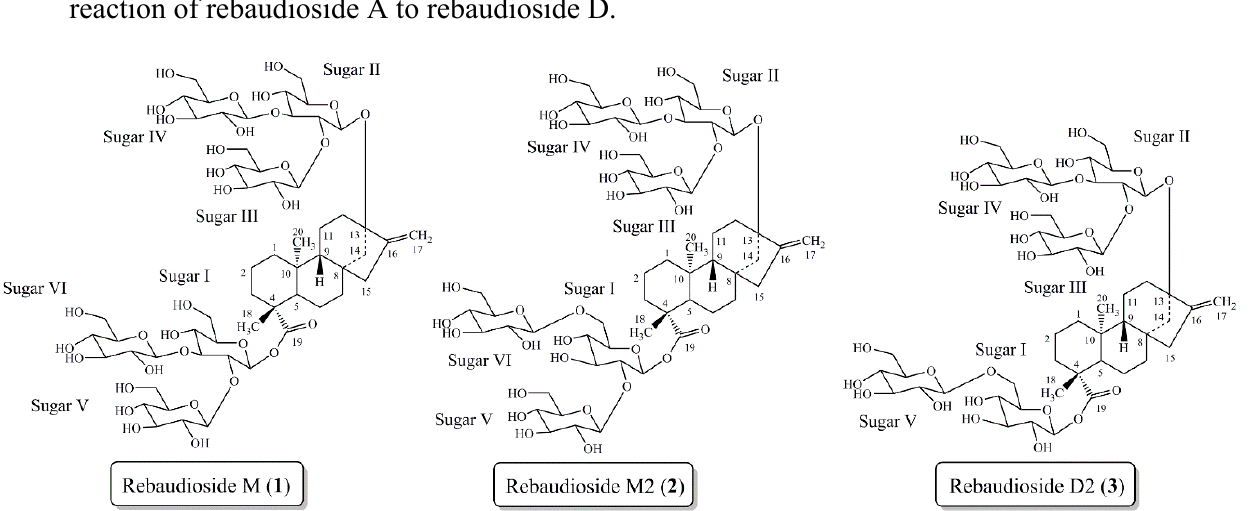
Figure 1. Steviol glycoside rebaudioside M ( 1 ) isolated from S. rebaudiana Bertoni. Steviol glycosides rebaudioside M2 ( 2 ) and rebaudioside D2 ( 3 ) isolated from the bioconversion reaction of rebaudioside A to rebaudioside